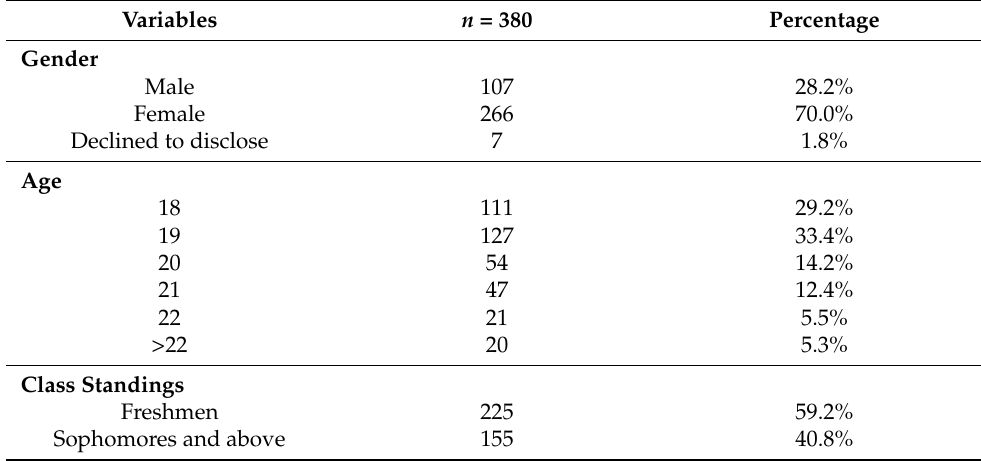
Table 1. Characteristics of surveyed